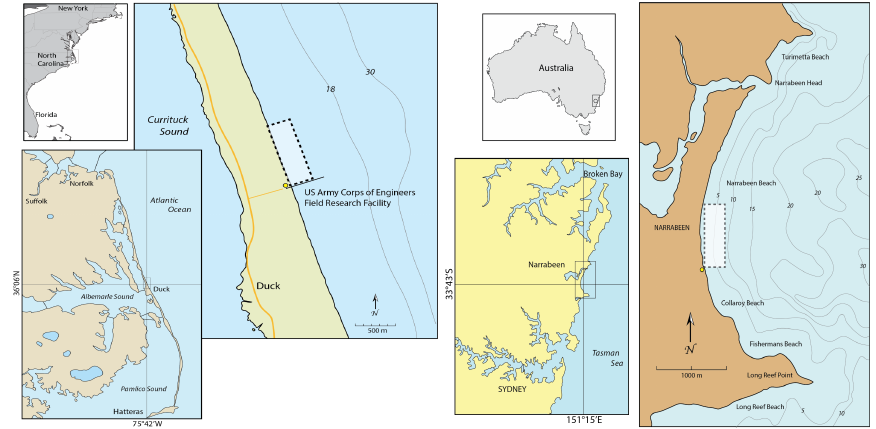
Figure 2. Maps illustrating the location of the two study sites, Duck ( left panel), and Narrabeen ( right panel). Dots show the camera locations and dashed boxes denote imagery